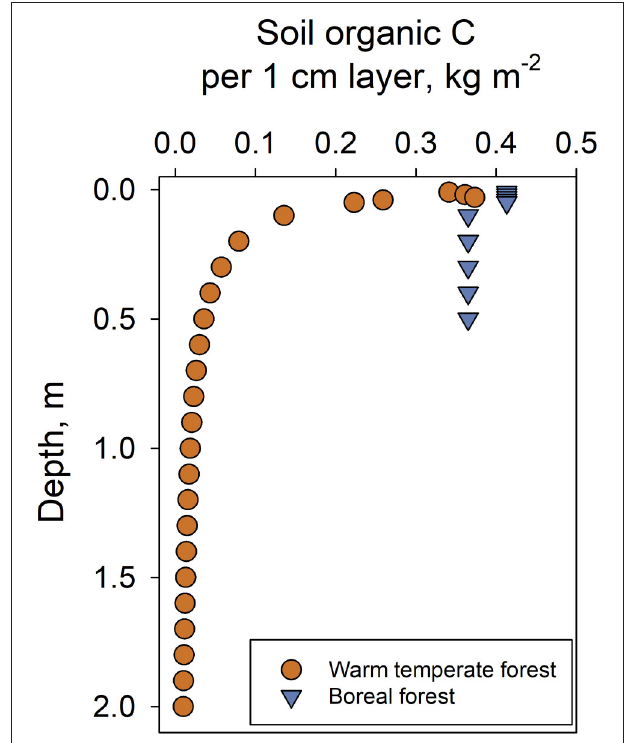
FIGURE 2 | Depth distributions of soil organic C (SOC) content in a warm temperate forest (Calhoun Critical Zone Observatory, South Carolina, USA) and a mesic boreal forest (Newfoundland and Labrador Boreal Ecosystem Latitudinal Transect, Canada) used as input parameters for the Soil Organic C Erosion Replacement and Oxidation-Deposition (SOrCERODe) model. Values are smoothed from actual values ( Markewitz and Richter, 1998; Ziegler et al., 2017 ). Note that soil profiles in the boreal forest are shallower than in the warm temperate forest. In the current study, each forest’s erosional and depositional profiles are assumed to exhibit these depth distributions prior to initiation of modeled erosion and deposition, allowing model users to investigate the influence of erosion, deposition, and SOC production and oxidation on profile SOC content